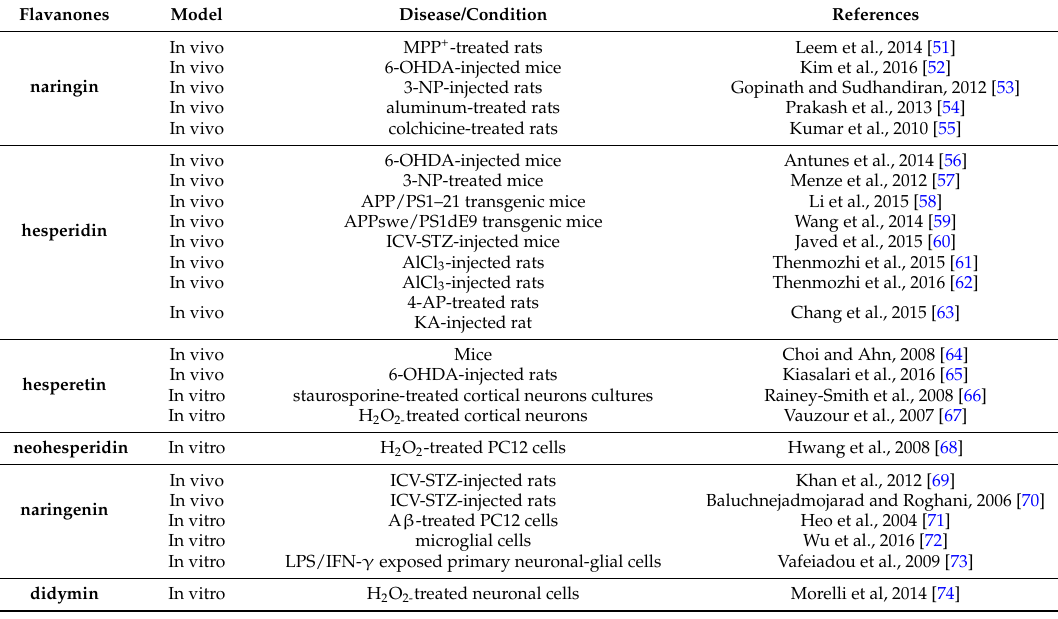
Table 1. Citrus flavanones and experimental models of neurodegenerative